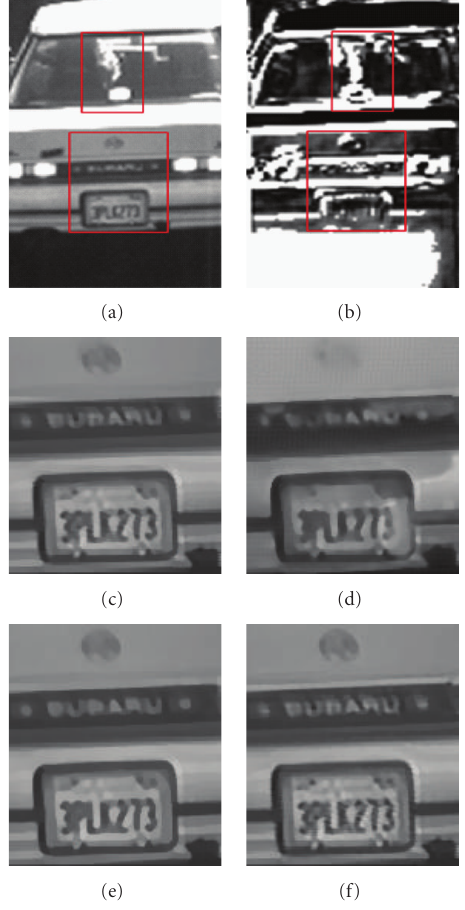
Figure 1: Car sequence: (a) the 1st LR image, (b) mixing parameter ζ 1 1 , reconstructed HR image using, (c) L 2 -norm-based [1], (d) L 1 - norm-based [2], and (e) and (f) proposed algorithm for Case I and Case II, respectively.